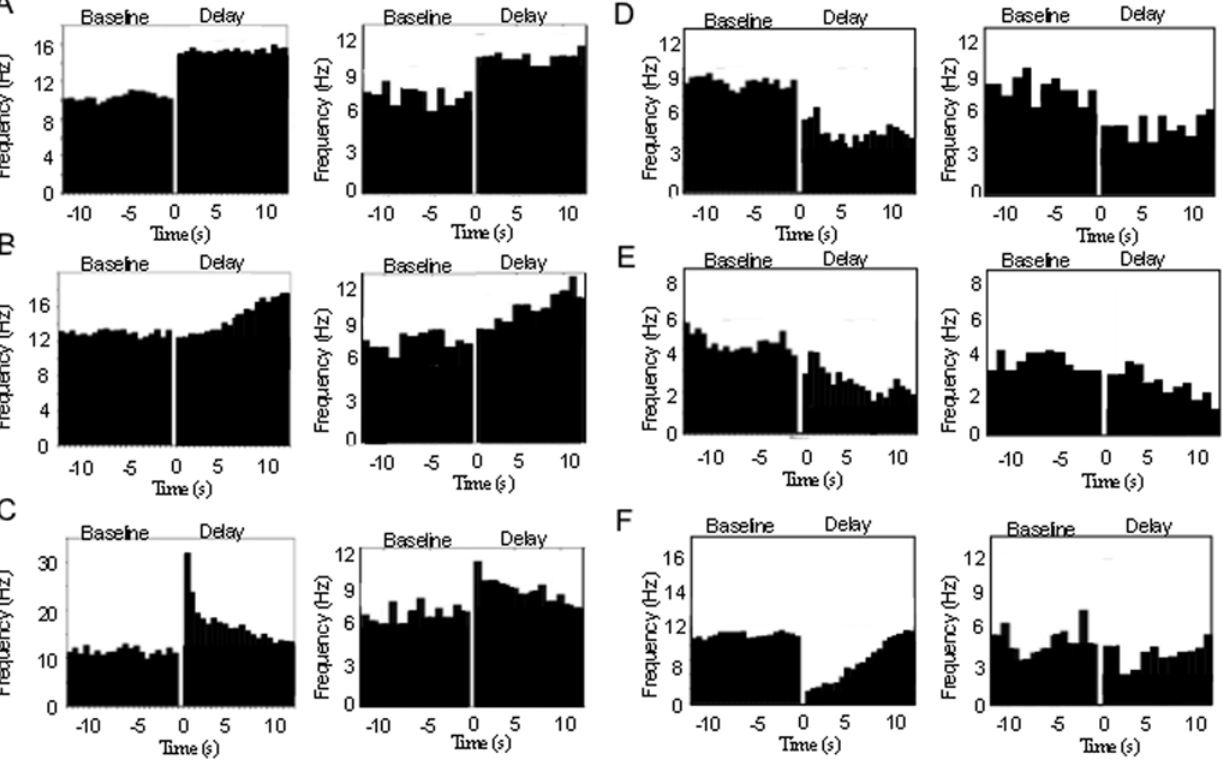
Figure 8. Average histograms from example units of the 2-population spiking model showing the excitatory and inhibitory working memory patterns, and average histograms from representative single neuron recordings from the database of prefrontal and parietal neurons exhibiting the same general patterns. PSTH histograms of spiking model units are shown in the left columns and real neuron histograms in the right columns. The gap between baseline and delay periods corresponds to the cue period (firing rate not shown). Histograms of the model units were averaged over 10 simulated trials of the working memory task. Patterns exhibited are A) Stable fixed rate memory (i.e. bistable) cell behavior, B) ramping cell behavior, C) decaying memory cell behavior, D) fixed rate inhibition cell behavior, E) ramping inhibition, and F) decaying inhibition.